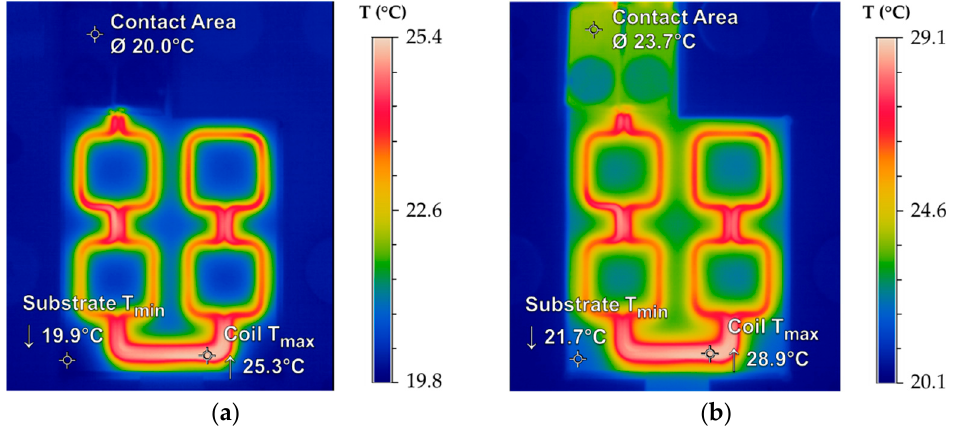
Figure 19. IR images of the coil self-heating for I 0 = 51.8 A and f 0 = 1.958 MHz: ( a ) Temperature input after t h = 1 s; ( b ) Temperature input after t h = 10